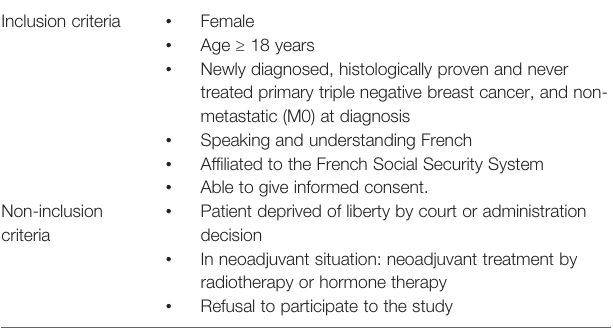
TABLE 2 | Inclusion and non-inclusion criteria. Inclusion